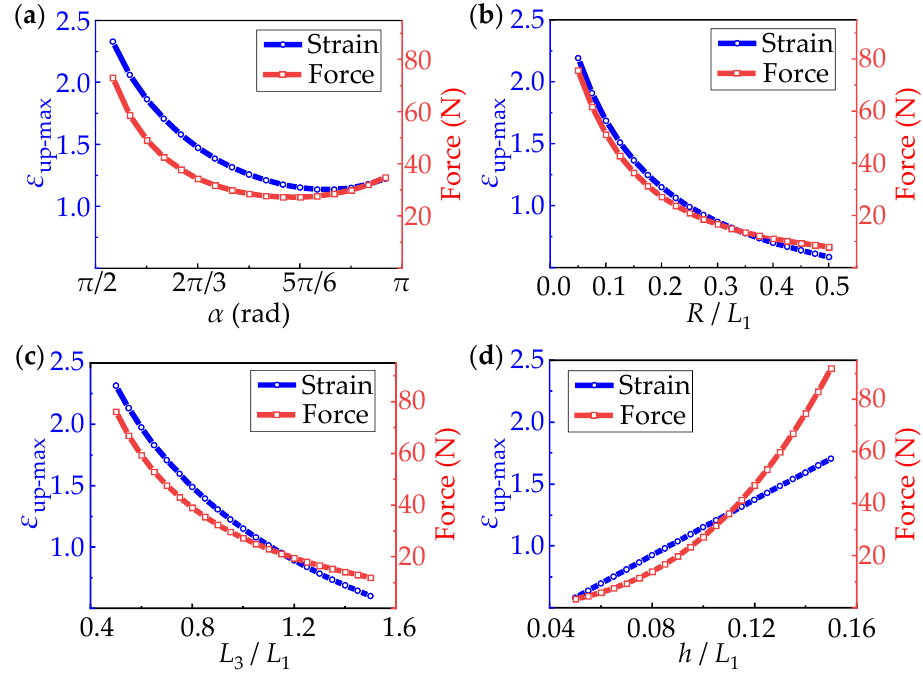
Figure 5. The influences of non-dimensional parameters ( a ) α ; ( b ) R / L 1 ; ( c ) L 3 / L 1 ; ( d ) h/ L 1 on strain and force of horseshoe-shaped structures during deformation.